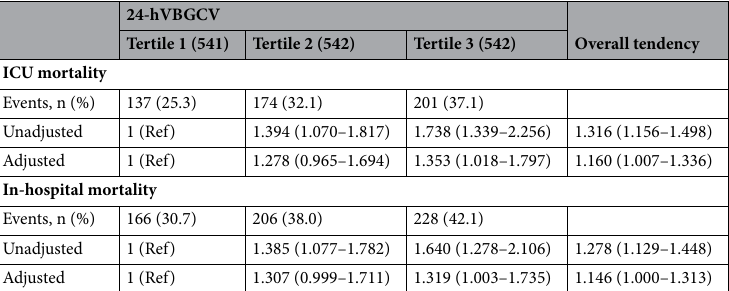
Table 2. Odds ratios (OR) and 95% confidence intervals (CI) for mortality associated with 24-hVBGCV in overall patients. Adjusted for age, sex, ethnicity, SOFA score, obesity, infection, diabetes, chronic pancreatitis, heart failure, renal failure, use of insulin. OR was for ICU mortality and hospital mortality. 24-hVBGCV coefficient of variation of 24-h venous blood glucose, ICU intensive care unit, SOFA sequential organ failure